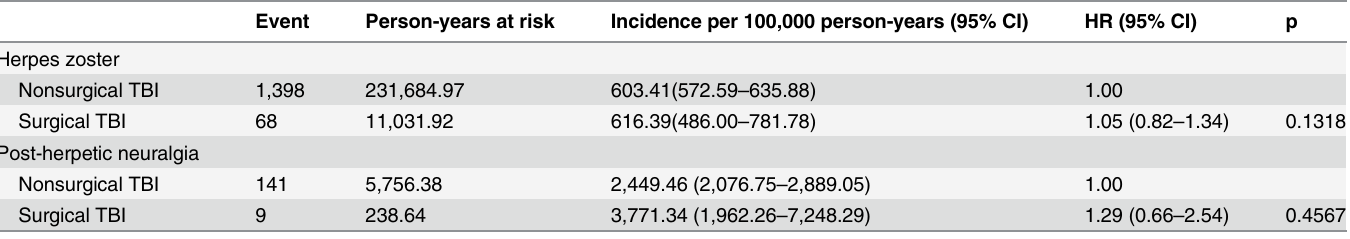
Table 7. Incidence and hazard ratios for herpes zoster and postherpetic neuralgia during the follow-up period for surgical versus nonsurgical trau- matic brain injury